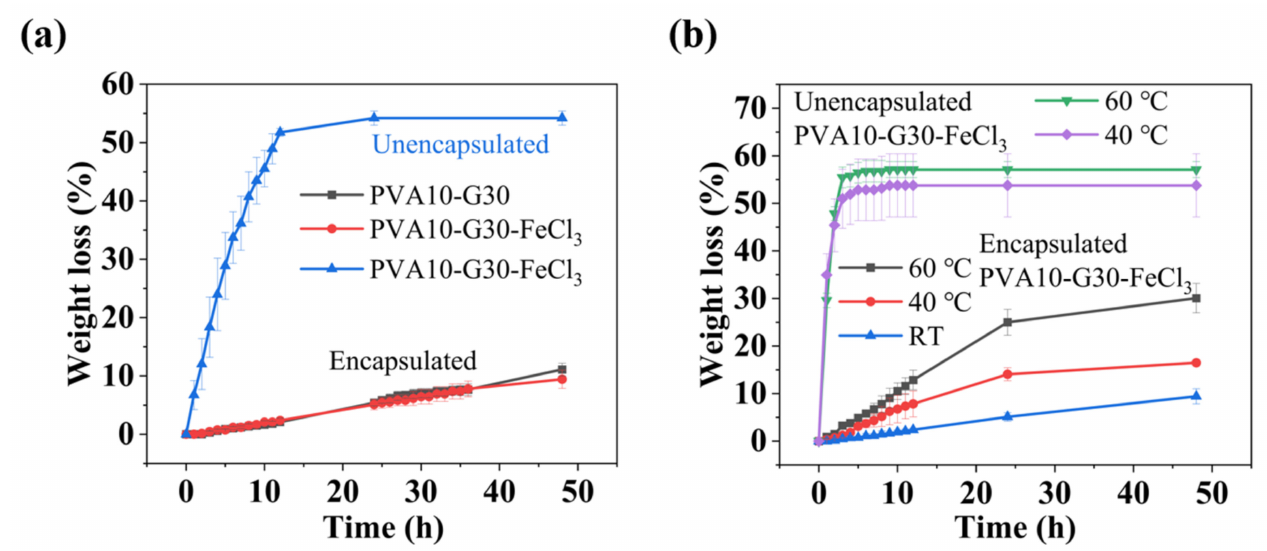
Figure 3. ( a ) Comparison of water retention between encapsulated and unencapsulated hydrogels exposed to air at room temperature (RT). ( b ) Comparison of water retention between encapsulated and unencapsulated hydrogels exposed to air at RT, 40 ◦ C, and 60 ◦